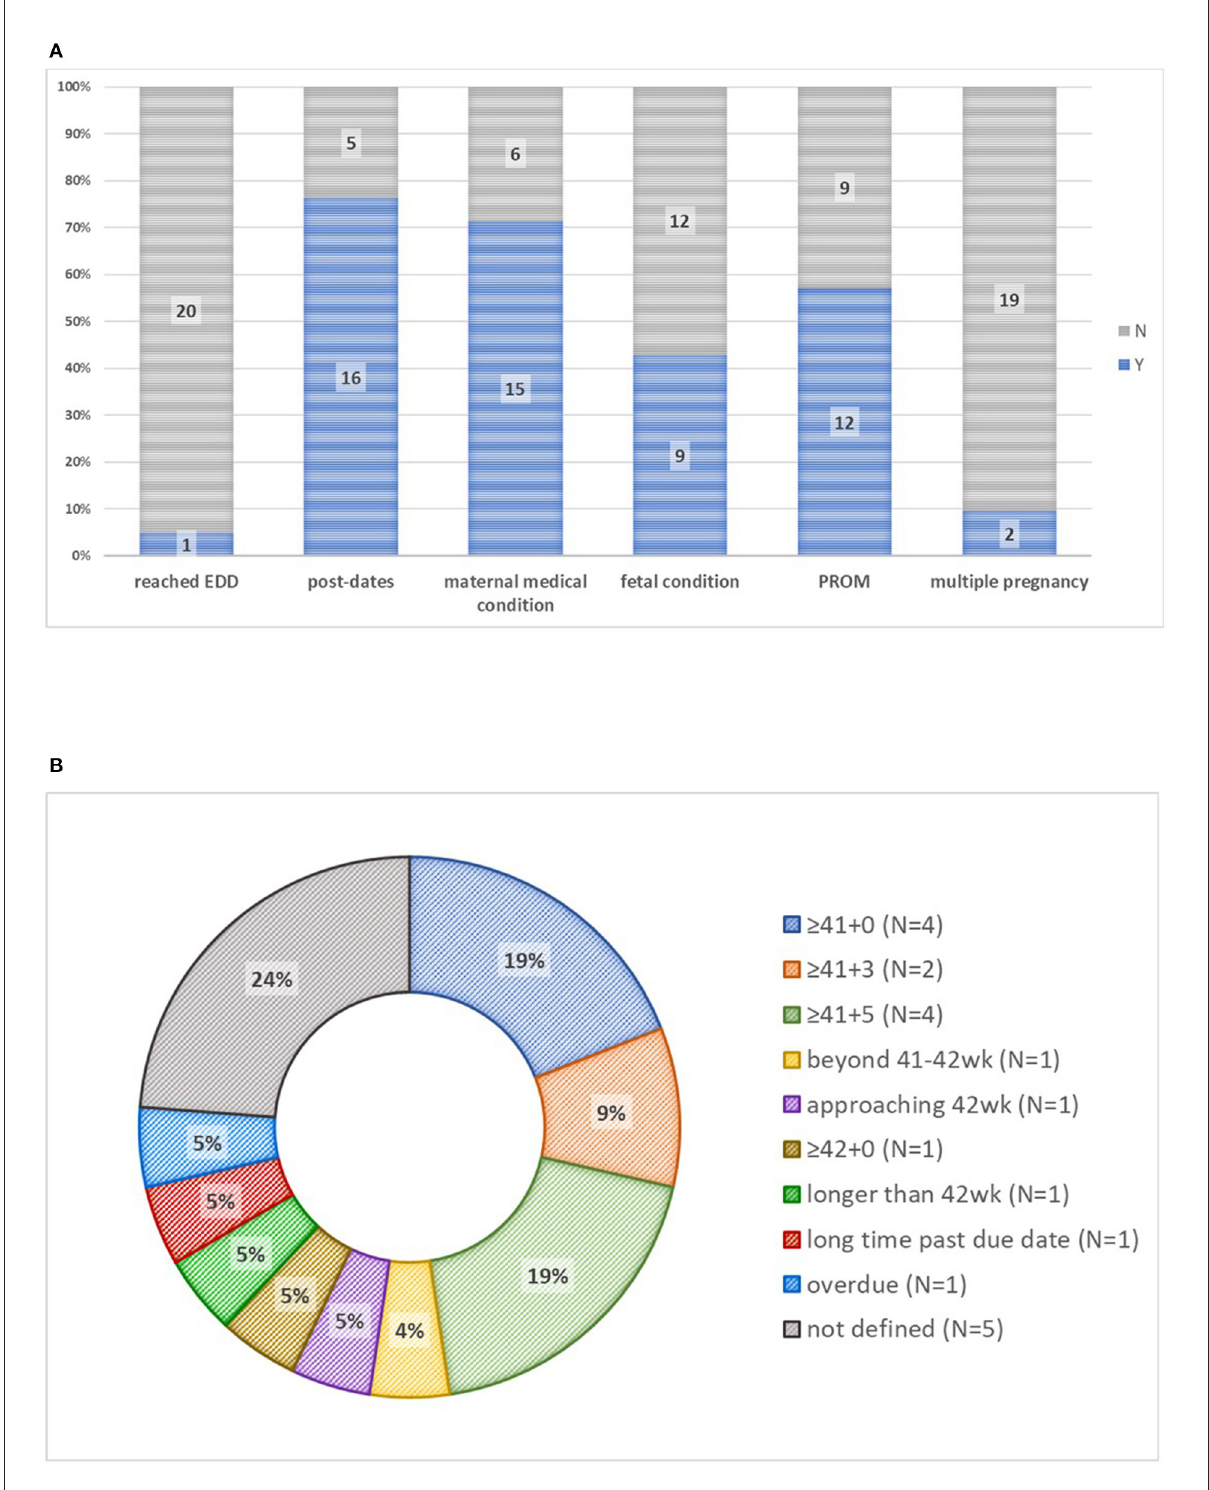
FIGURE1 Indications for induction of labor and definitions of postdates in 21 patient information leaflets. (A) Indications for induction of labor. (B) Definitions of post-dates. EDD, estimated due date; PROM, prolonged rupture of membranes.